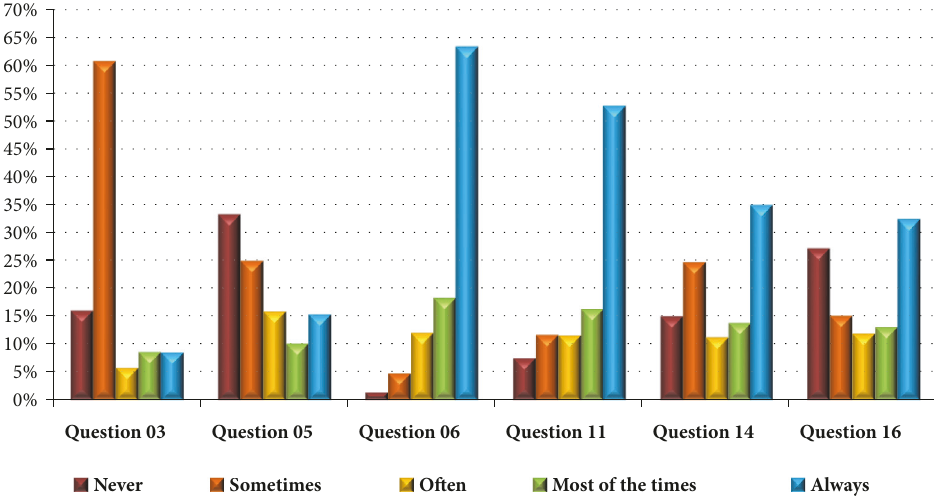
Figure 2: Relative frequency of answers to six questions of the questionnaire, in the frequency